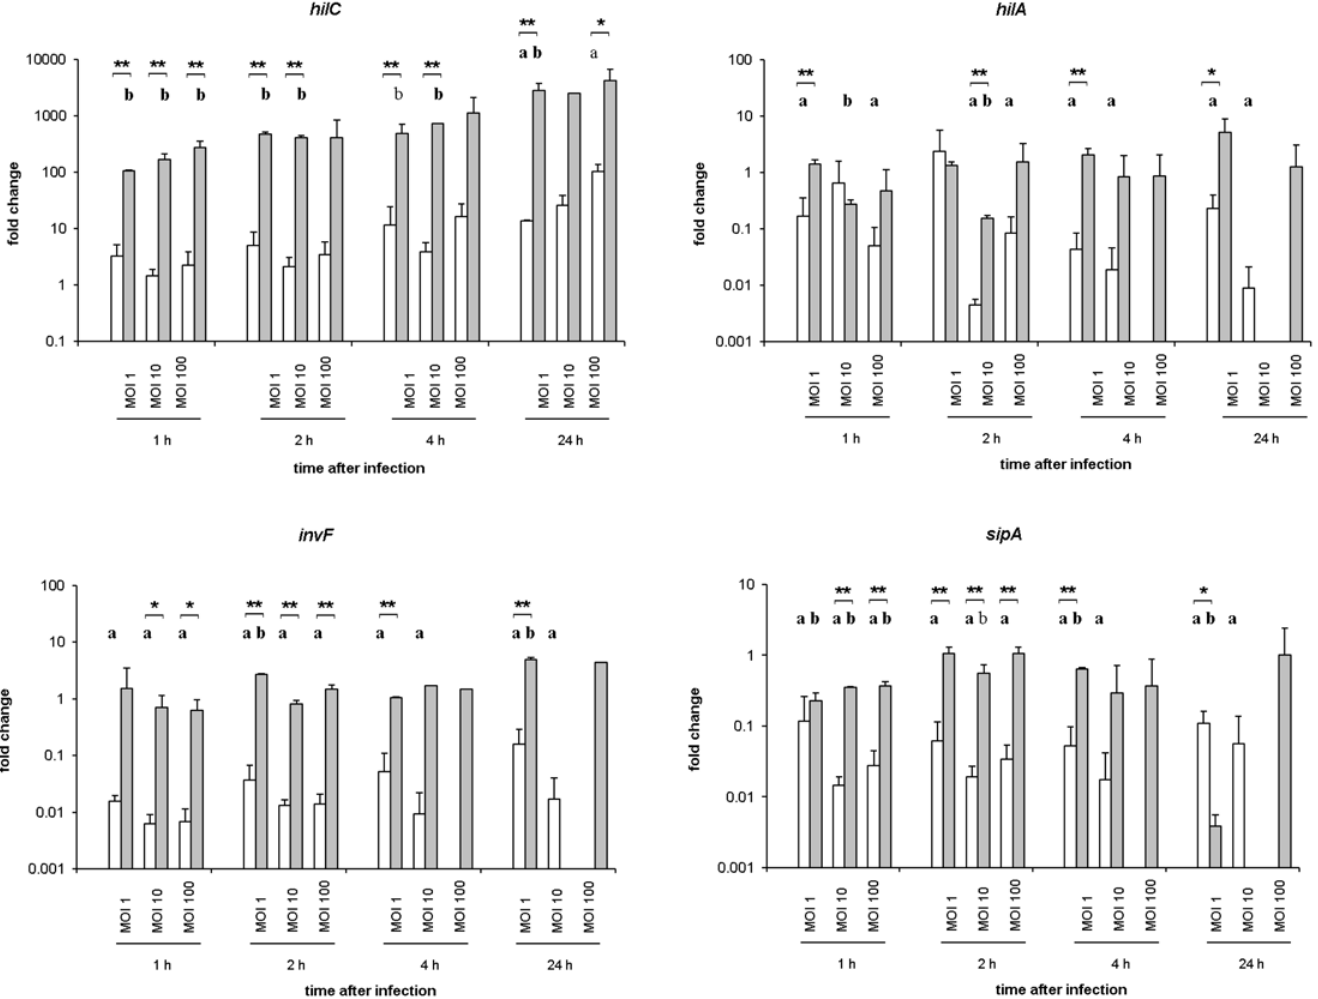
Fig 7. mRNA expression levels of SPI-1-associated genes of S . Typhimurium and S . Infantis in avian splenic macrophages. Data were presented as fold change compared to bacteria before infection. White columns — macrophages infected with S . Typhimurium (n = 6), Grey columns — macrophages infected with S . Infantis (n = 6) ** P (cid:2) 0.05 or * P (cid:2) 0.1 S . Typhimurium vs. S . Infantis; a ) P (cid:2) 0.05 or a) P (cid:2) 0.1 S . Typhimurium vs. control; b ) P (cid:2) 0.05 or b) P (cid:2) 0.1 S . Infantis vs.